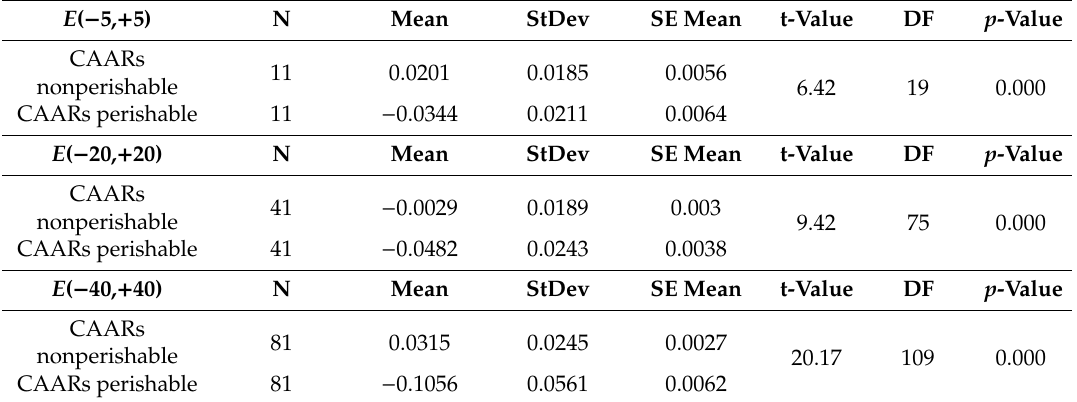
Table 7. Summary of T-test on CAARs subsamples.